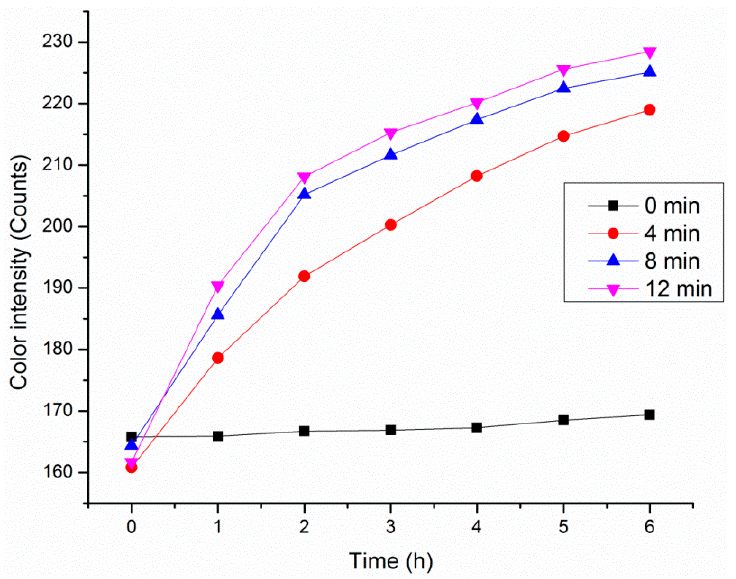
Figure 7. Evaluation of photocatalytic performance of ZnO-nanorod-coated cotton fabrics. A proposed mechanism for the photocatalytic degradation of Orange II dye by ZnO nanorods under UV irradiation is shown in Figure 8. When the ZnO is illuminated by energy higher than its band gap (3.37 eV), the electrons in the valence band jump to the conduction band followed by generation of electron (e − ) and electric hole (h + ) pairs on the surface of the photocatalyst. The negative electrons (e − ) and oxygen (O 2 ) combine to form a superoxide radical (O 2 − ), while the positive holes (h + ) and water (H 2 O) produce hydroxyl radicals (OH). Finally, the generated hydroxyl radicals (OH) and the superoxide radical (O 2 − ) are responsible for the Orange II dye degradation [45,46]. A proposed chemical reaction is shown as follows (Equation (5)–(8)):